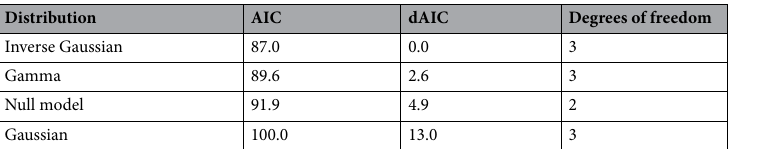
Table 3. Comparison of fit between models of the relationship between reserve size and the ratio of brown hyaena density estimated using differing assumptions of fence permeability.